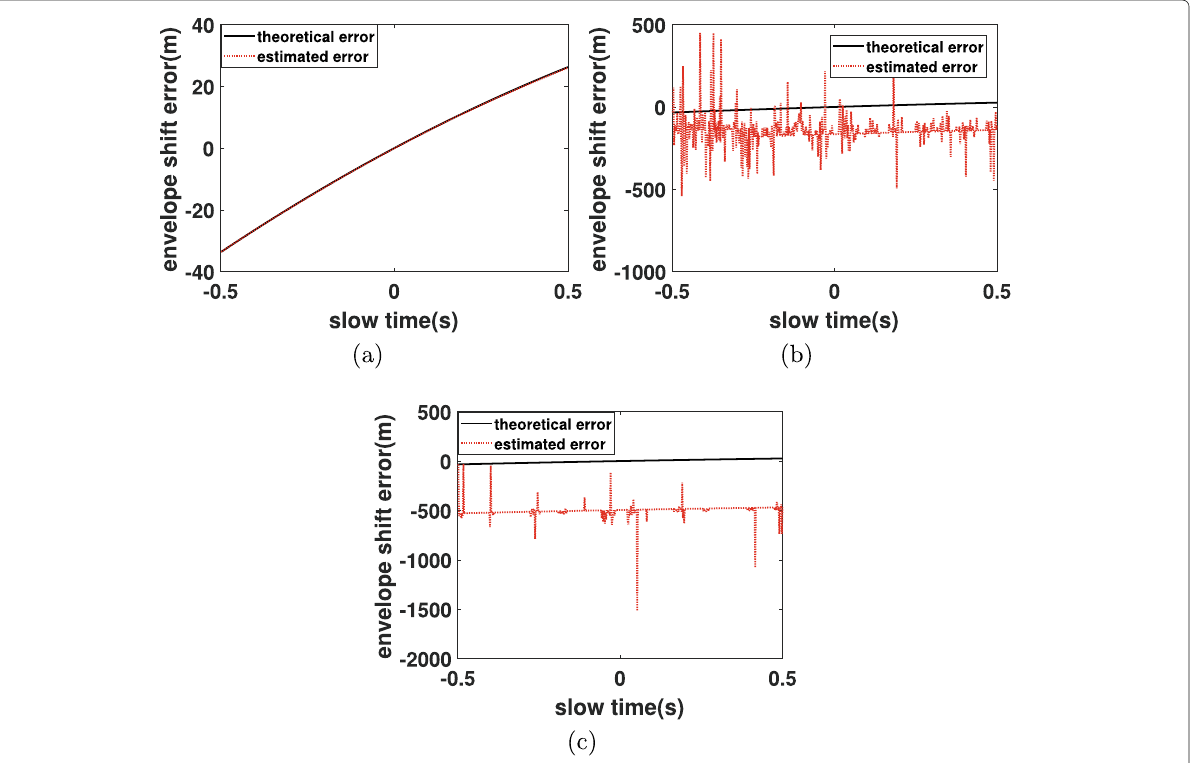
Fig. 5 Estimated error curves of the three methods under a − 10 dB SNR. a The estimated error curve of the proposed algorithm, b the estimated error curve of the ACM, and c the estimated error curve of the